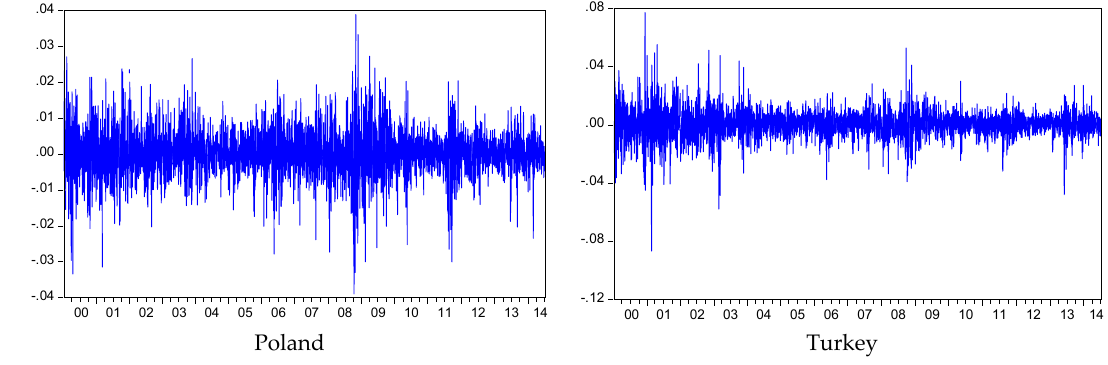
Figure 1. Index returns of Croatia, Greece, Poland and Turkey (4 January 2004–3 July 2014).